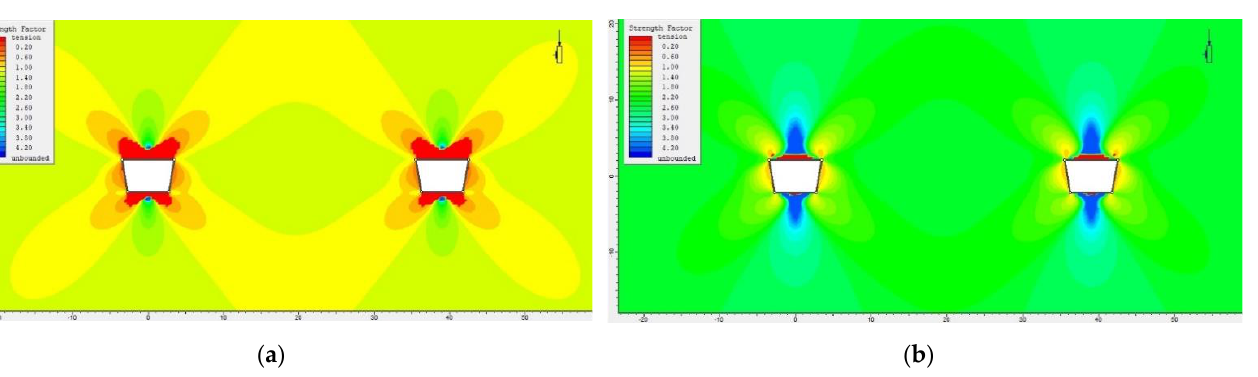
Figure 14. Distribution of strength factor values in the cross-section through ramps drilled in: ( a ) sandstone; ( b ) dolomite.